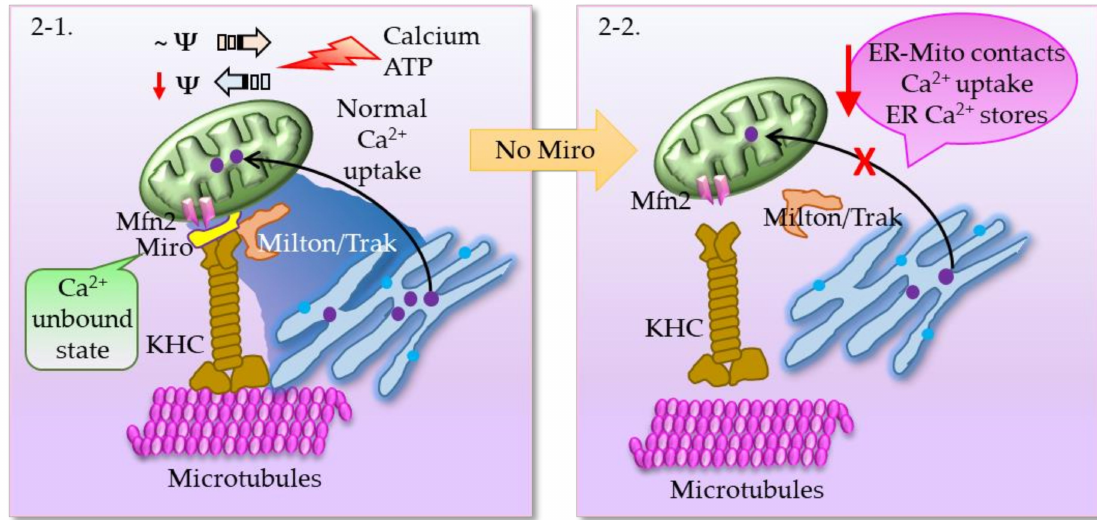
Figure 2. ( 2-1 ) Mitochondria move along the microtubules in response to changes in the local Ca 2+ and ATP, in other words, buffering and metabolic demand. Mitochondria with normal membrane potential perform anterograde movement (move towards the periphery), whereas loss of membrane potential results in increased retrograde transport towards the cell body. The cargo adaptor proteins, mitochondrial Rho (Miro) GTPases and Milton, link mitochondria to microtubules via kinesin heavy chain (KHC). Miro binds Milton in a Ca 2+ -unbound state, and thus mitochondria become attached to microtubules. When Miro binds Ca 2+ , it is dislodged from Milton and mitochondria are uncoupled from microtubules. Moreover, Miro1 and Miro2 are required for normal mitochondrial cristae architecture, ER–mitochondria contact sites, and a normal Ca 2+ uptake. ( 2-2 ) Absence of Miro results in decreased ER–mitochondria contacts, as a consequence of which ER/mitochondrial handling of Ca 2+ is severely affected, and there is a significantly larger loss of Ca 2+ from ER